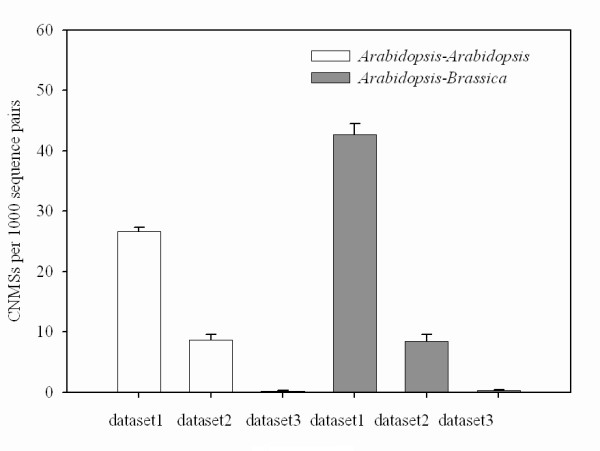
Occurrences of CNMSs in the random datasets. Dataset 1, dataset 2 and dataset 3 respectively correspond to the 1000 homologous pairs, the 1000 shuffled pairs of noncoding sequences and the 1000 random pairs of genomic sequences in the analysis. Sequence length is 500 bp. Occurrences of CNMSs were analyzed in analogous manner for 10 different random sets with equal data size. Means of CNMS occurrences are indicated on the y axis, and error bars represent SEs.